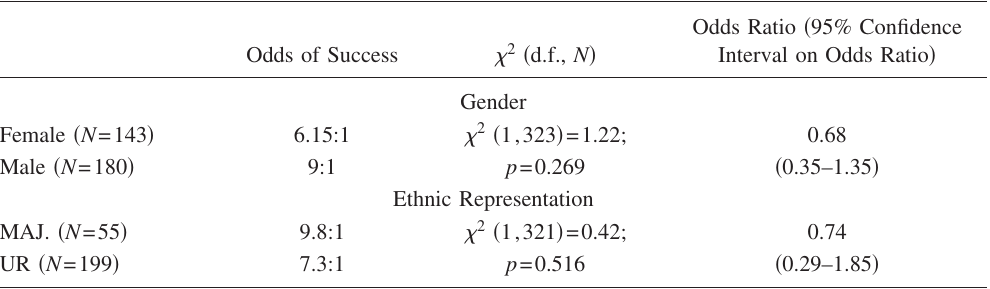
TABLE III. (cid:3) 2 test of independence on students in MI’s odds of success (cid:1) succeeding over not succeeding (cid:2) .